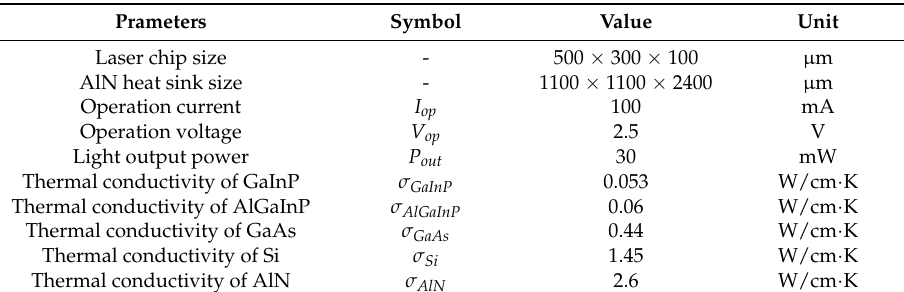
Table A1. Parameters for calculation.